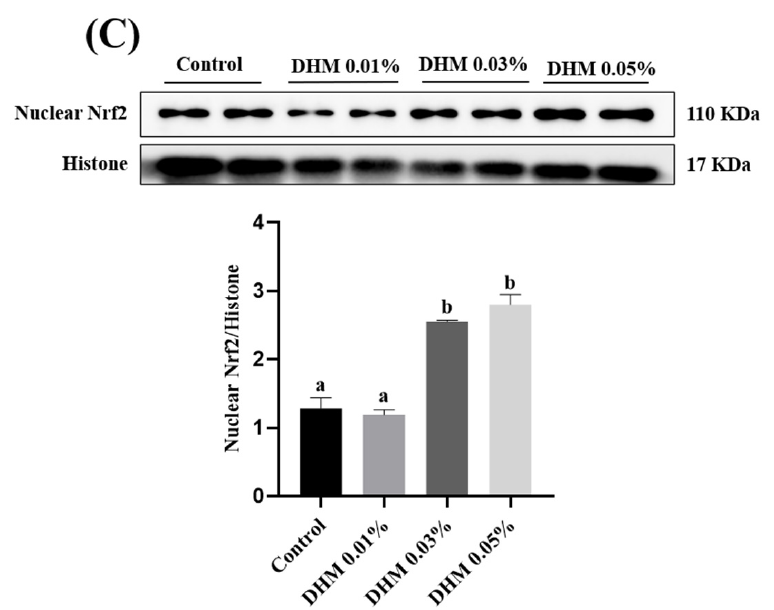
Figure 1. Effects of dietary DHM supplementation on antioxidant protein expression in the jejunum mucosa of growing-finishing pigs. ( A ) The protein level of NQO1. ( B ) The protein level of HO-1. ( C ) The protein levels of nuclear Nrf2. Data are expressed as the mean ± SE. Values with different superscript letters are significantly different ( p < 0.05).